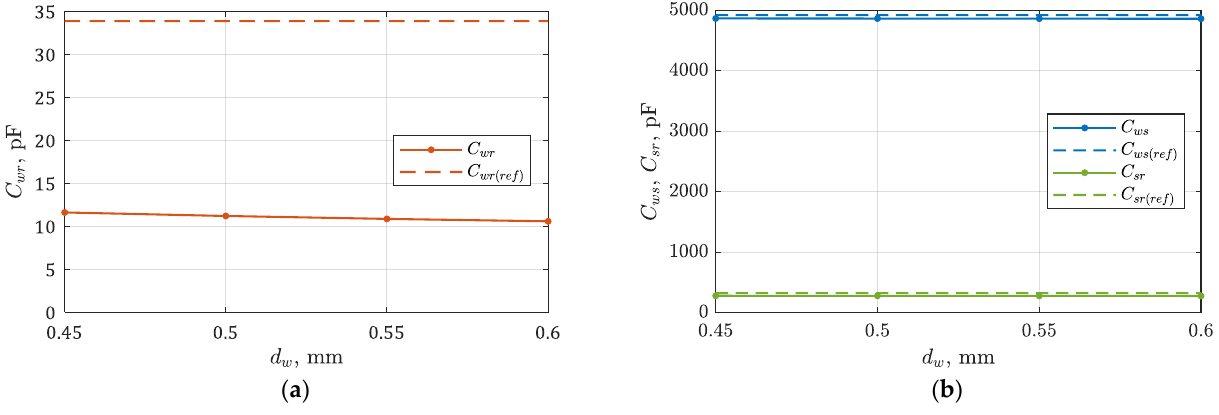
Figure 12. The results of the calculations of parasitic capacitances: C wr ( a ) and C ws , C sr ( b ) for different diameters of the shielding wire and the length of the end-winding overhang l ew = 2.5 mm compared to the capacitance values of the reference model.